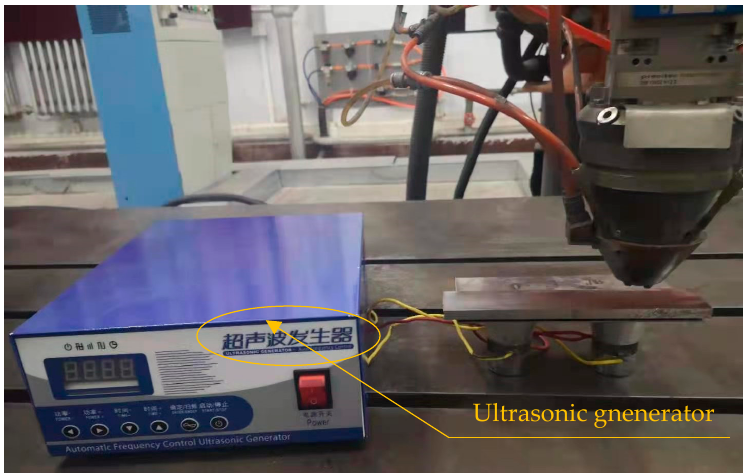
Figure 1. Experimental equipment for ultrasonic assisted laser cladding.